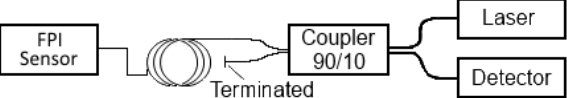
Figure 2. Schematic view of the readout system used to detect changes in the length of the elastic element in the FPI sensor. No light reflects at the terminated fiber